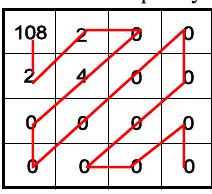
Fig.3. DCT coefficients discarding in zig-zag order with MGS